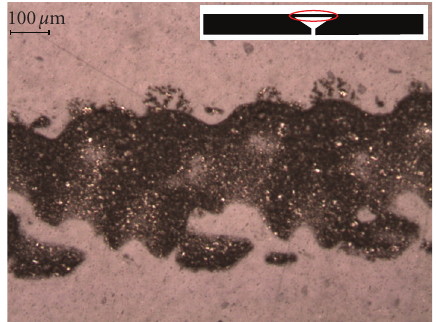
Figure 11: Narrow conductive line in antenna, printed with gravure